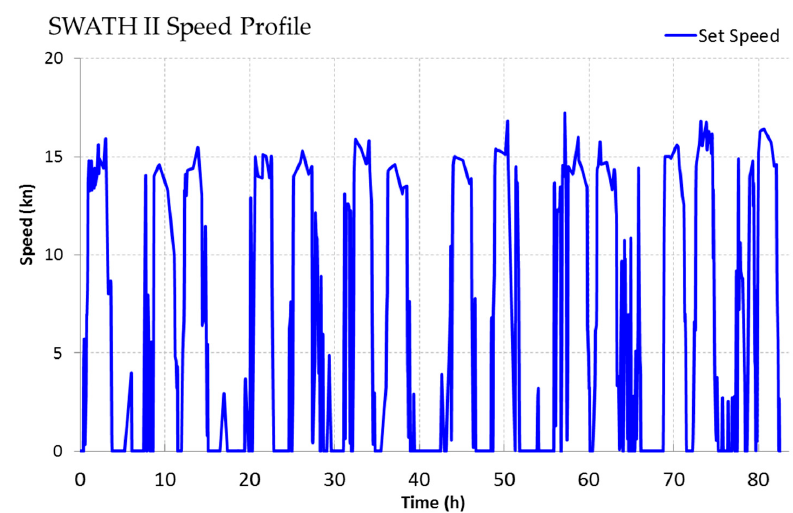
Figure 19. Ship transition route speed profile of a SWATH II type ship.